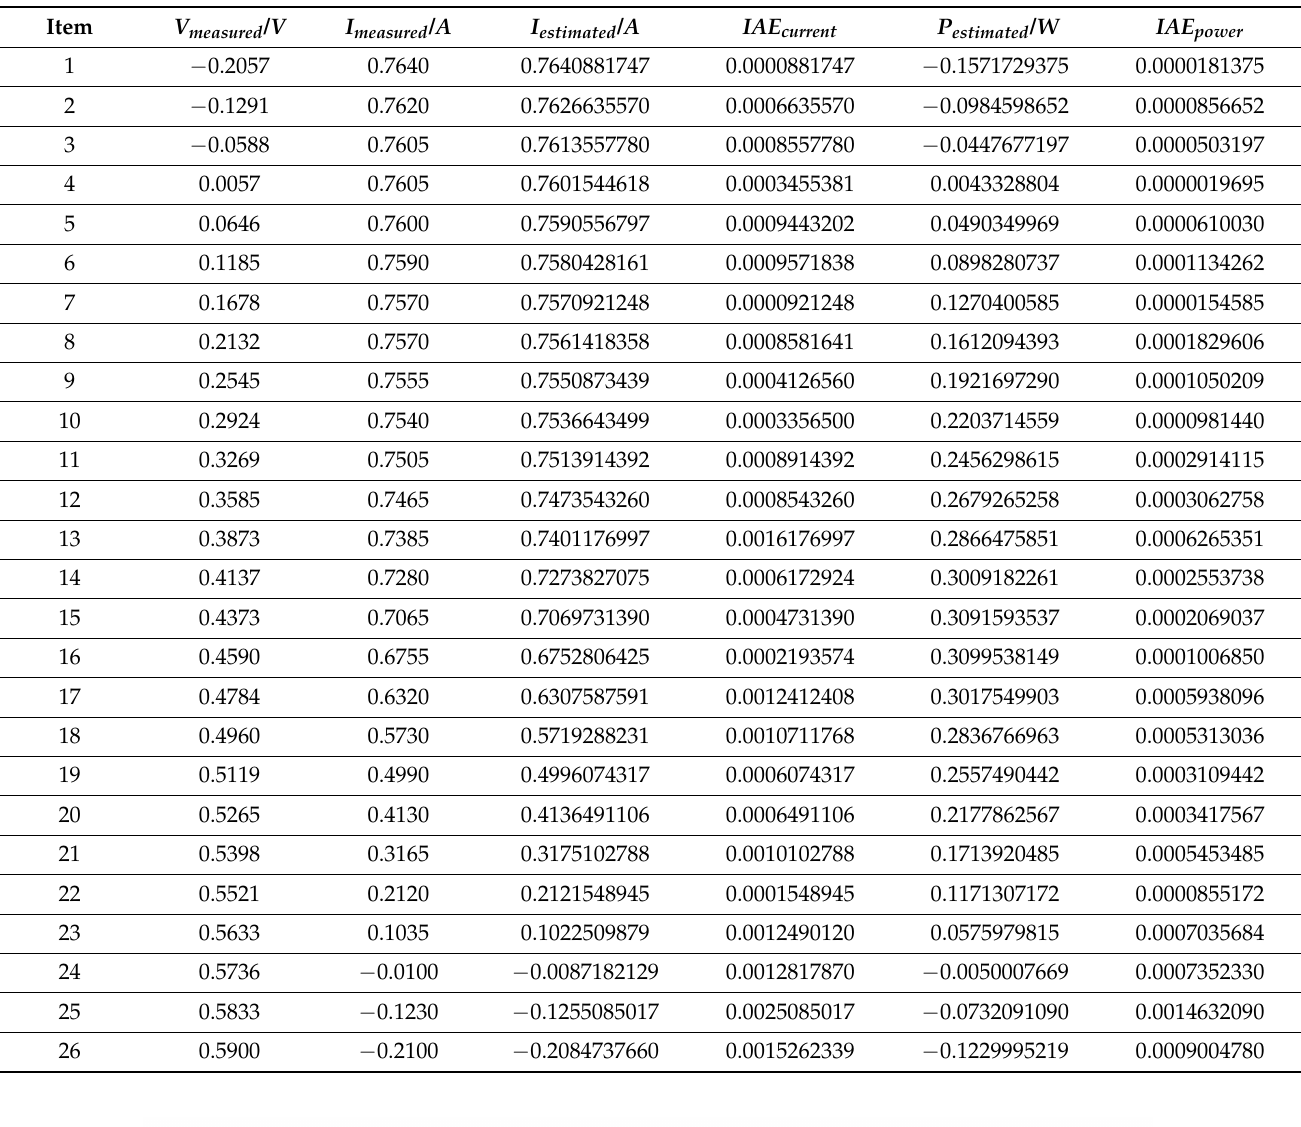
Table 6. IAE of CSOOJAYA for the SDM.